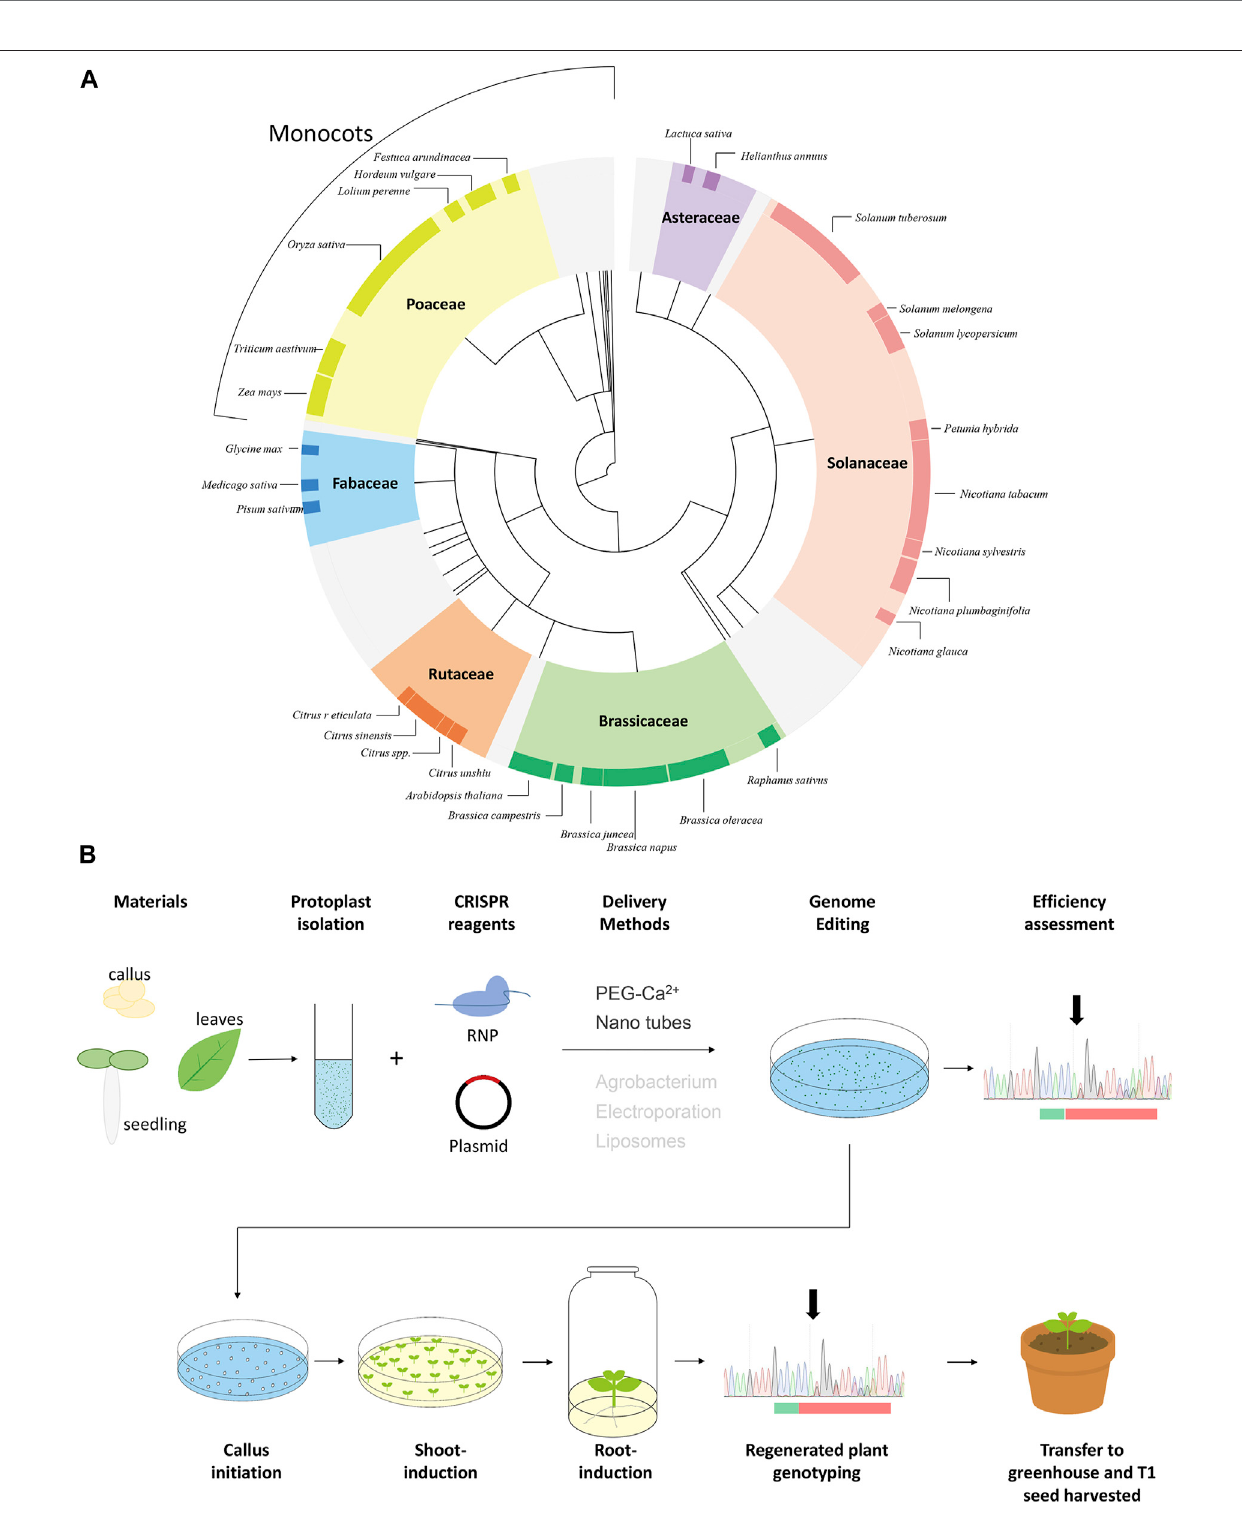
FIGURE 1 | Protoplast regeneration and CRISPR genome editing. (A) Protoplast regeneration-related articles according to taxonomy. These 779 protoplast regeneration articles were identi fi ed from Google scholar and NCBI ( Supplementary Table S1 ). The taxonomy of the plant species follows the Angiosperm Phylogeny Group IVsystem and NCBI taxonomy. Major familes are color coded as follows: purple; Asteraceae, light orange; Solanaceae, green; Brassicaceae, orange; Rutaceae, blue; Fabaceae, yellow-green; Poaceae. The names of the species reported in more than fi ve articles are shown. The rest of the species are shown in grey. The information used to create this diagram is shown in Supplementary Table S1 . (B) Schematic of tobacco protoplast regeneration. Delivery methods stated in grey are the methods used for protoplast transformation that can theoretically be applied in genome editing. The multiple peaks (black arrows in “ Ef fi ciency assessment ” and “ Progeny genotyping ” ) in the upstream of PAM (green boxes) are indicated. tThe target site (red boxes) is editied by CRISPR reagent.